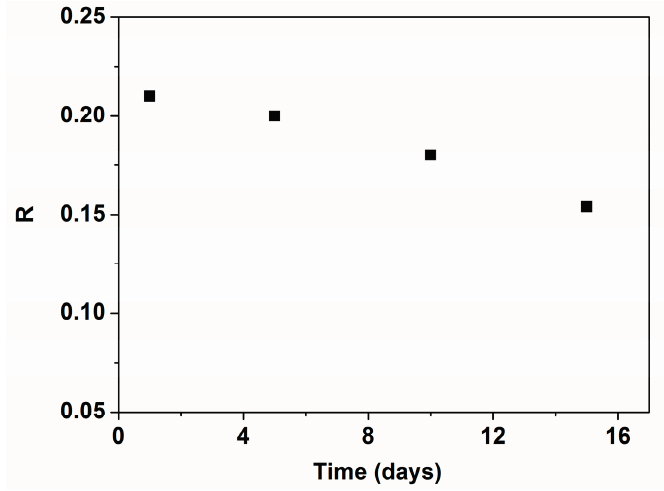
Figure 12. The response of P3HT-ZnO sensor for 1, 5, 10 and 15 days when exposed to 100 ppm